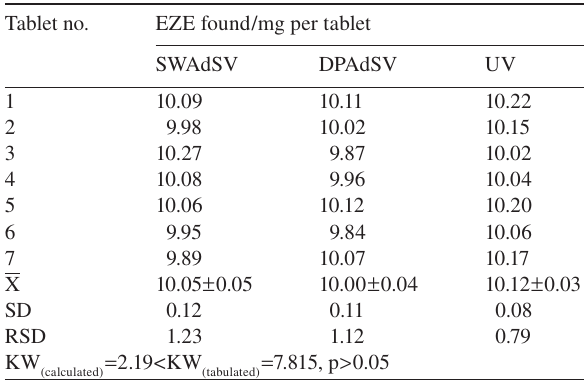
Figure 11 Voltammograms of synthetic preparation, tablet and standard solution for SWAdSV (228.00 ng/ml EZE).